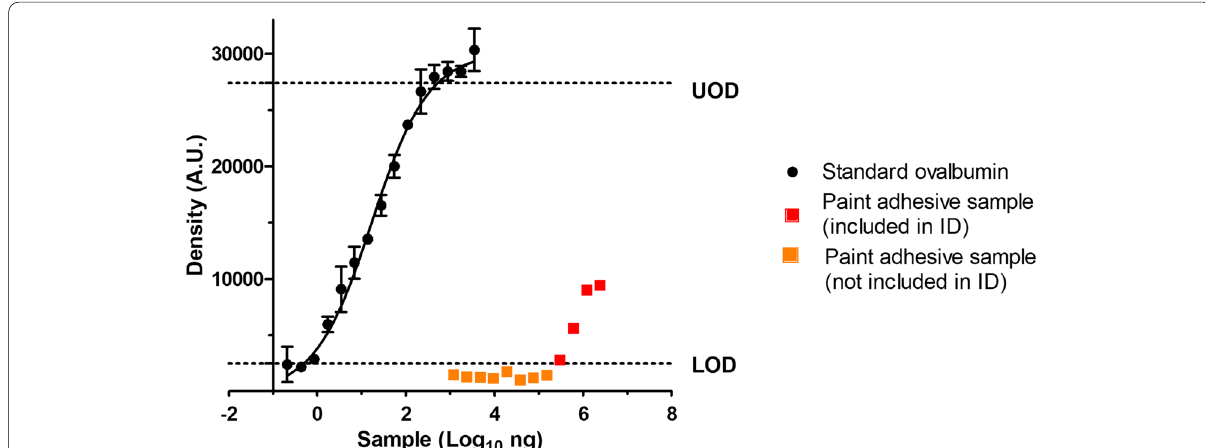
Fig. 4 Density value of standard ovalbumin (black circle) and ovalbumin extracted from paint adhesive sample (orange and red square) against the sample quantity. The logistic dose-response curve of standard ovalbumin and the interval of detection (ID) are reported. UOD, upper limit of detection; LOD, lower limit of detection. Density values of paint adhesive samples included in the ID are reported in red; those not included in the ID are reported in